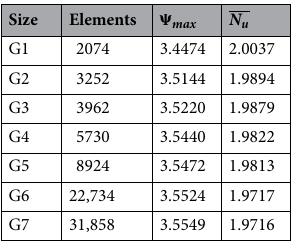
Table 2. Grid independent test for (cid:31) max and N u at Ra = 10 4 , Ha = 25, Ω = 0 and N = 5.